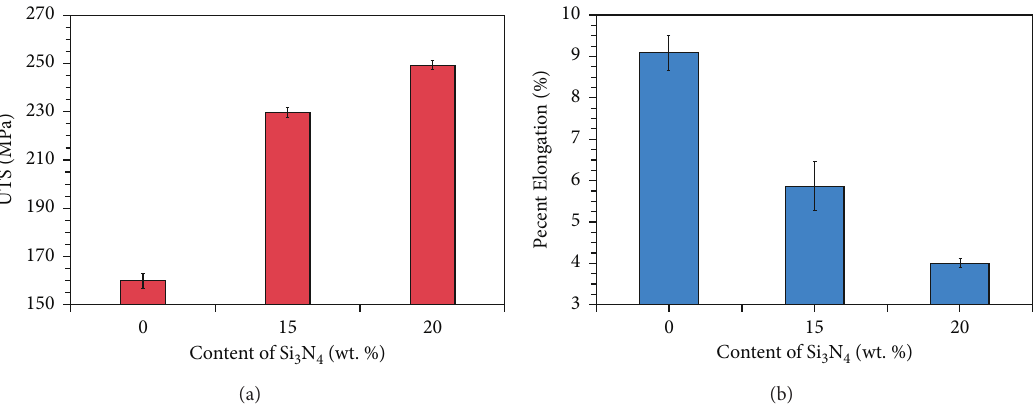
Figure 8: Effect of weight percentage of Si 3 N 4 on microhardness and macrohardness of the Al/Si 3 N 4 composite.